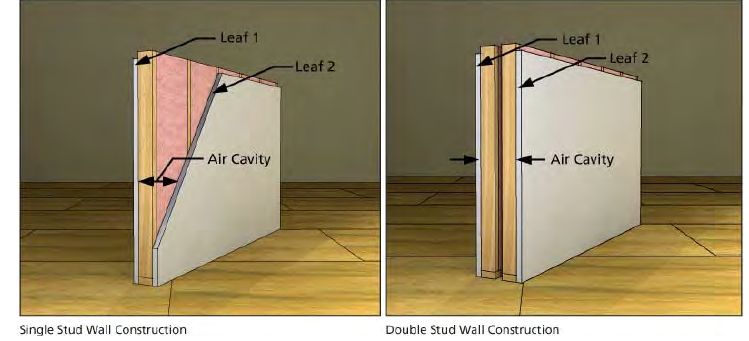
Figure 8. DoubleWall systems (soundproofingcompany.com)